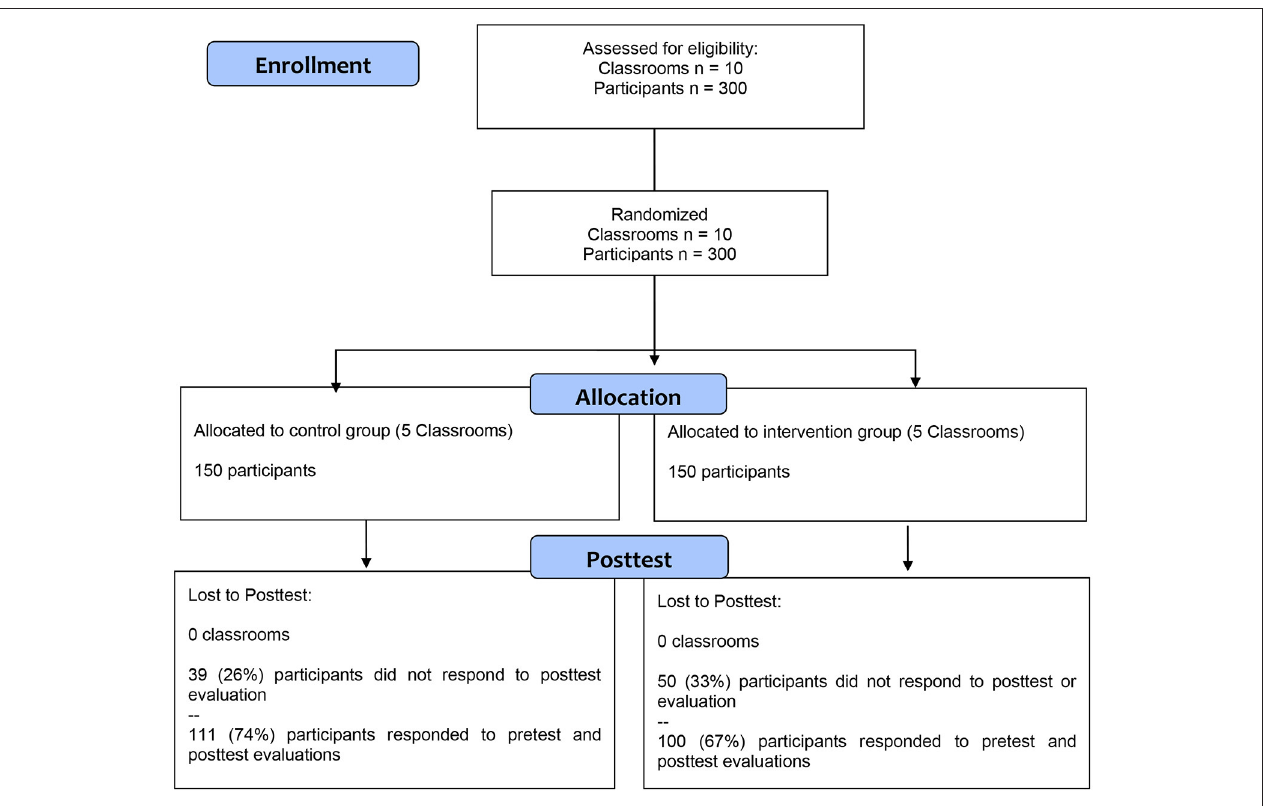
FIGURE 1 | Participant flow